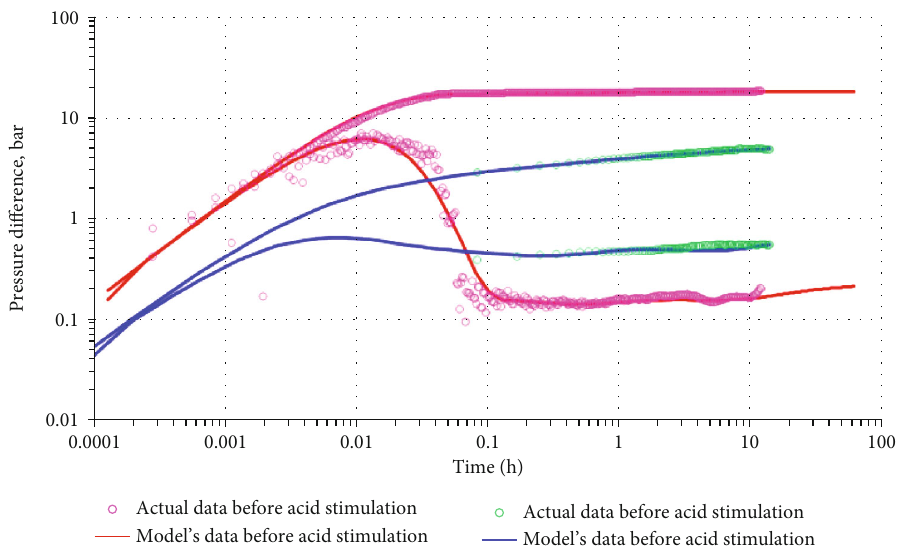
Figure 11: The pressure buildup interpretation comparison of P-3 before and after acid